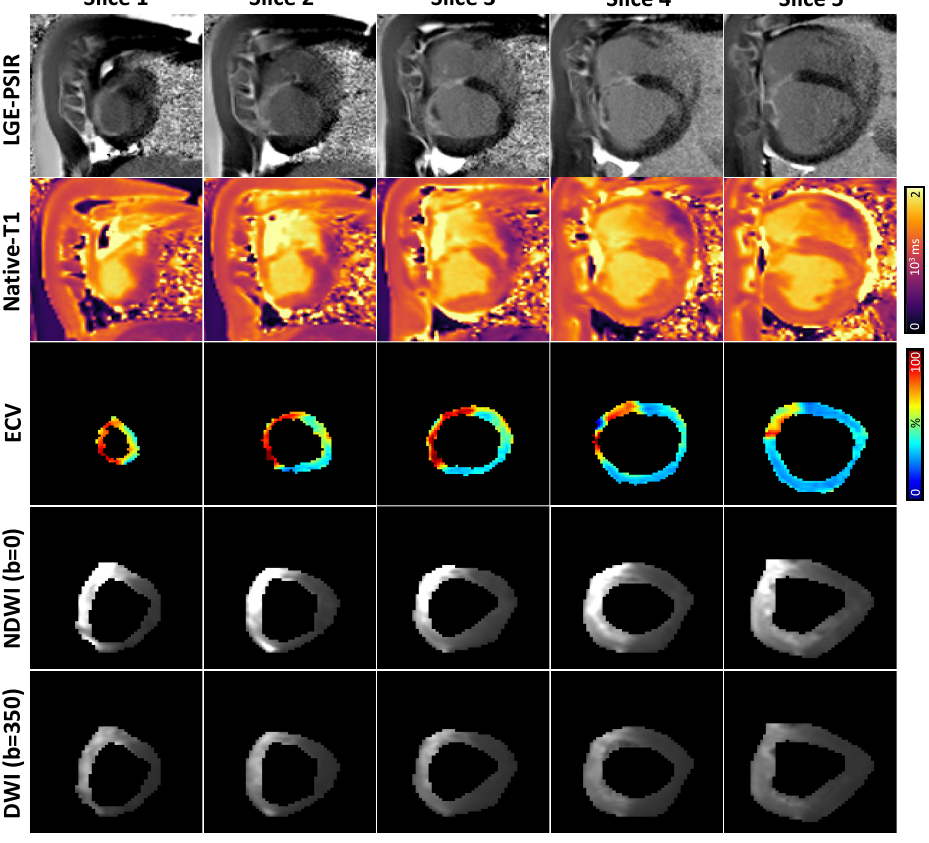
Figure 3. LGE-PSIR, native T1, ECV maps, b = 0 s/mm 2 , and b = 350 s/mm 2 images for five repre- sentative short-axis slices of the same infarcted swine subject. LGE-PSIR is a contrast-based imaging technique, and native T1 and diffusion images (NDWI and DWI) are non-contrast-based